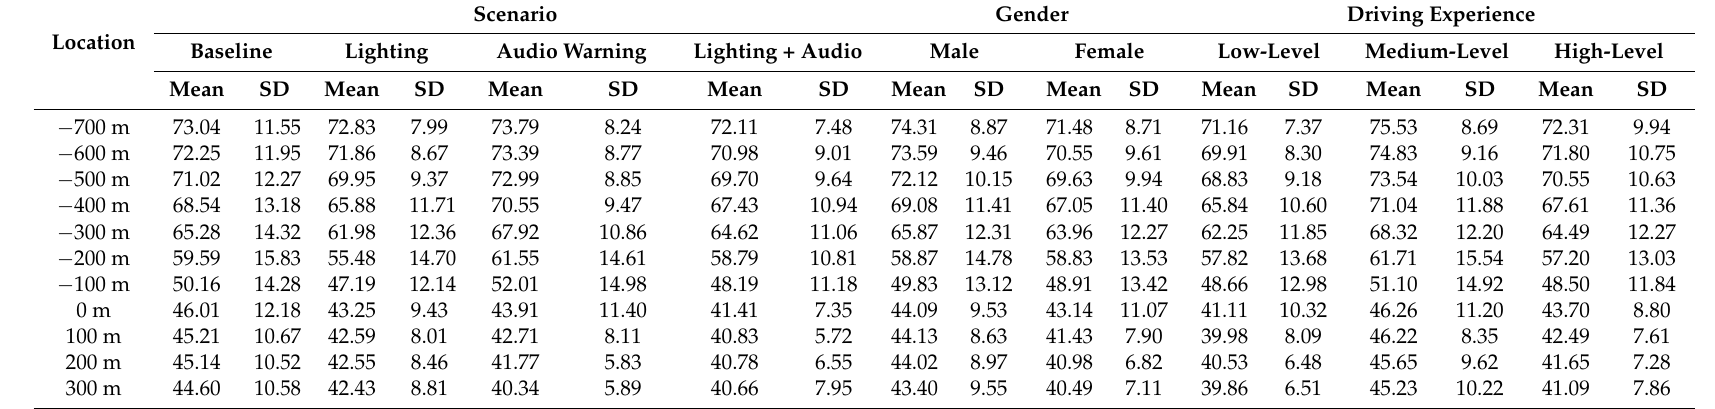
Table 1. Descriptive statistical results for average operating speeds for different scenarios, genders and driving experiences at different locations.